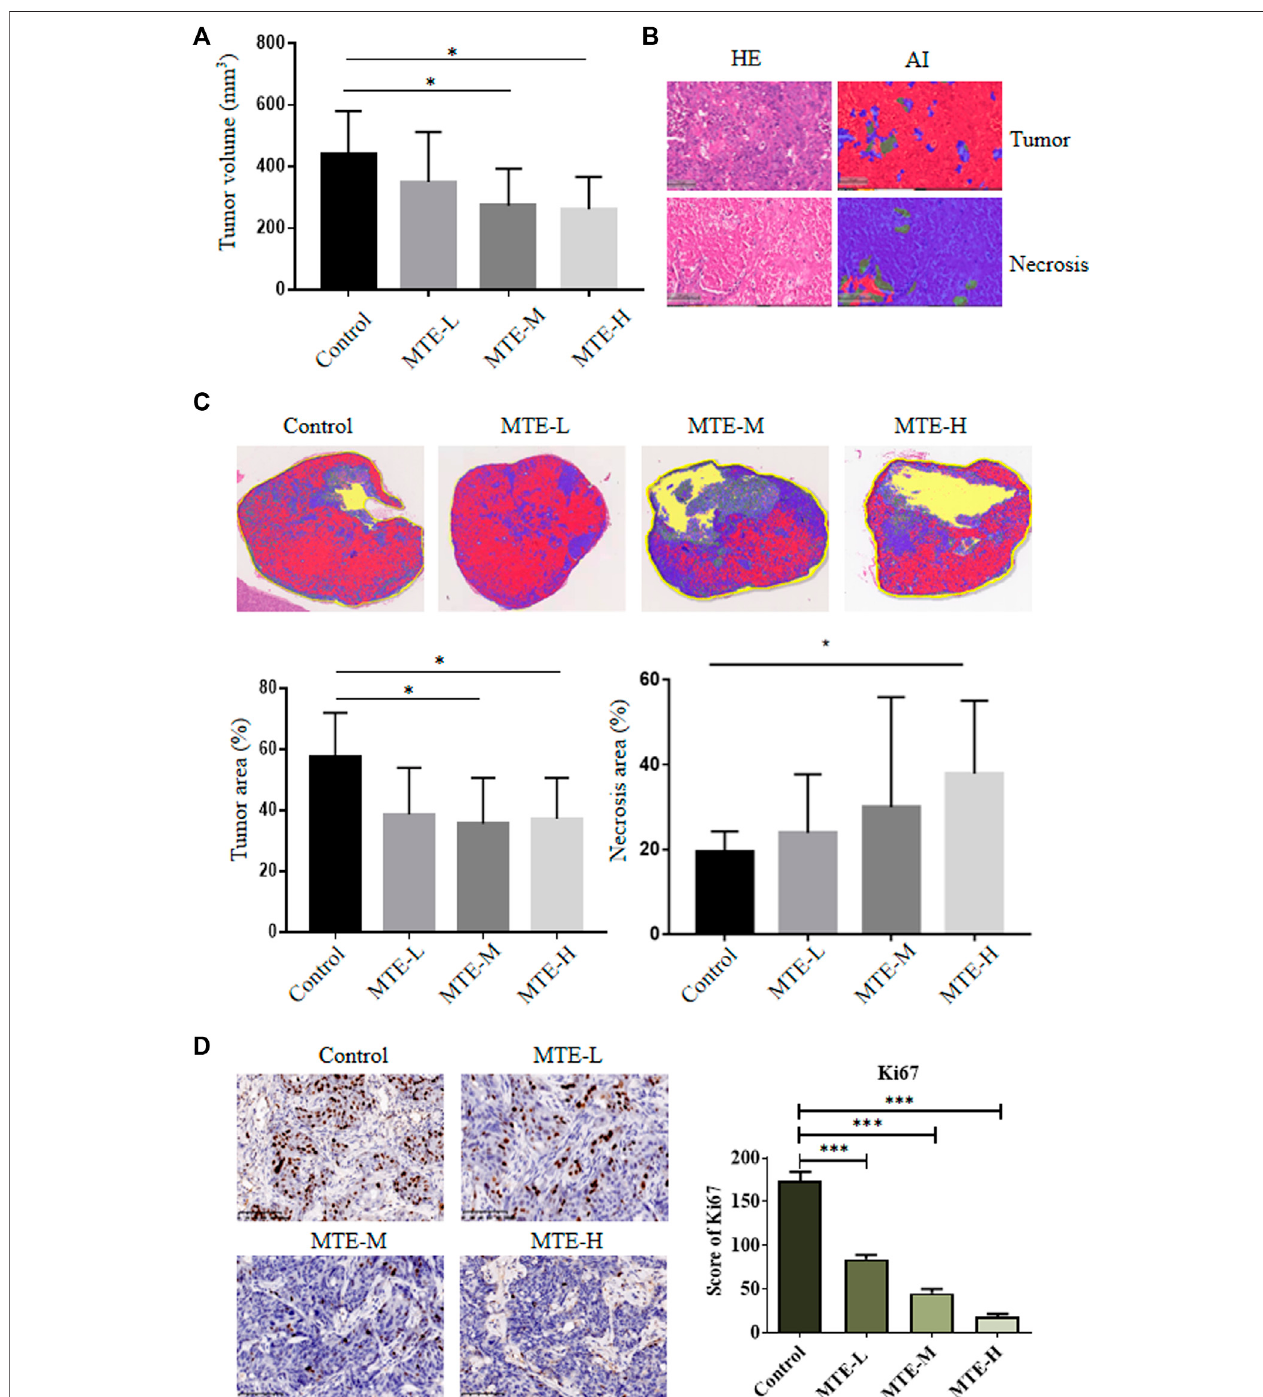
FIGURE4| MTEincreasedthetumornecroticareaandinhibitedtumorgrowthofHCC-PDXs. (A) HCC-PDXsweretreatedwithdifferentdosesofMTE(L:5 mg/kg; M: 10 mg/kg; H: 20 mg/kg) for 2 weeks, and tumor volumes were measured. (B) AI techniques were used to display the tumor area (red) and necrotic area (blue). Magni fi cation of HE: ×100. (C) Representative whole-slide images of the tumor labeled by AI algorithm and the percentage of tumor cells and necrotic area are plotted. (D) RepresentativeimagesofKi67stainingonslidesofHCC-PDXs.Magni fi cationofIHC:×200.HE,hematoxylinandeosin;AI,arti fi cialintelligence.* p < 0.05.*** p <